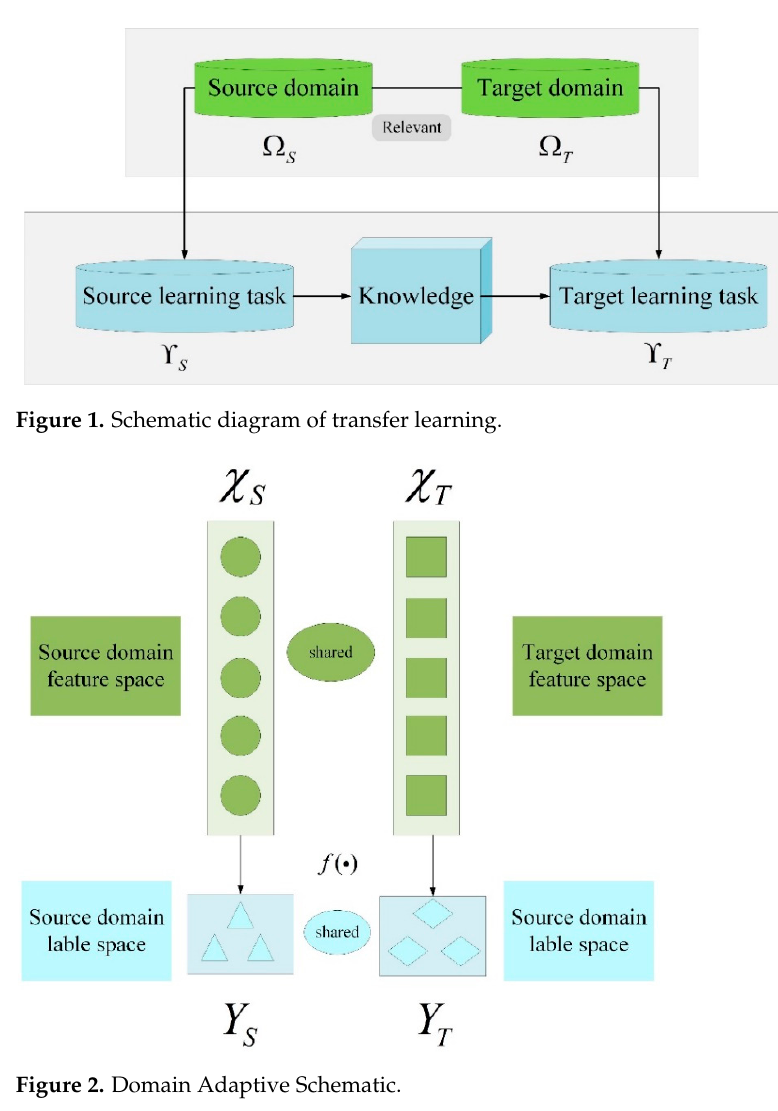
Figure 1. Schematic diagram of transfer learning.